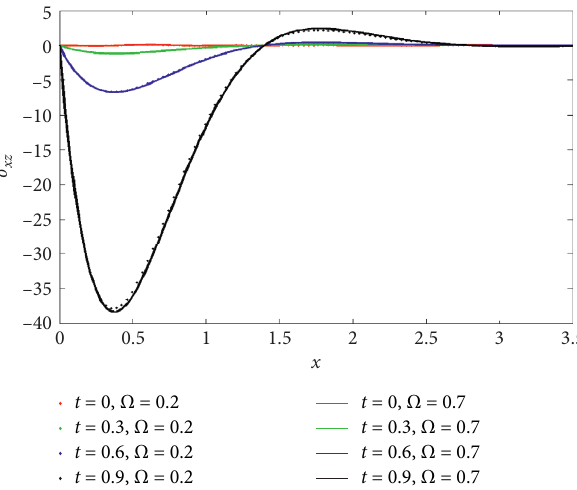
Figure 19: Vertical displacement w concerning x with laser pulse “ t ” and rotation.